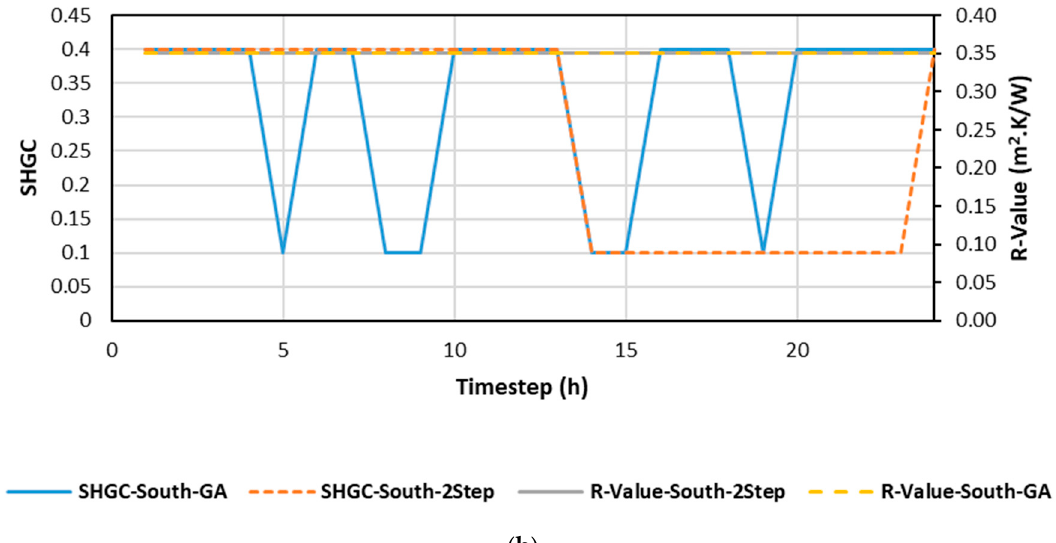
Figure 11. Hourly variations of ( a ) R-values and SHGC settings, and ( b ) thermal loads for an STIS–smart window with southern exposure during a Winter day (18 December) for a dwelling located in Phoenix, AZ, USA.